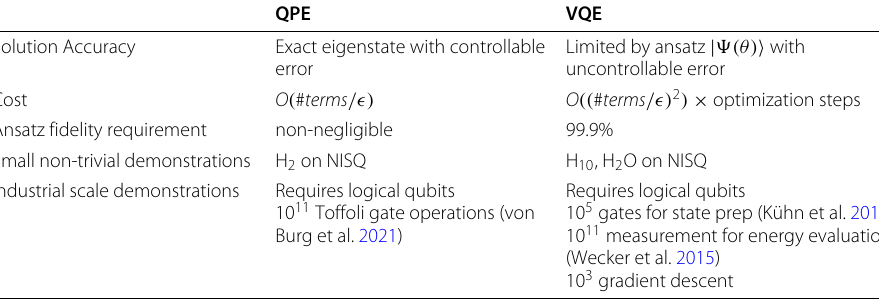
Table 2 Comparison of QPE and VQE algorithms QPE VQE Solution Accuracy Exact eigenstate with controllable